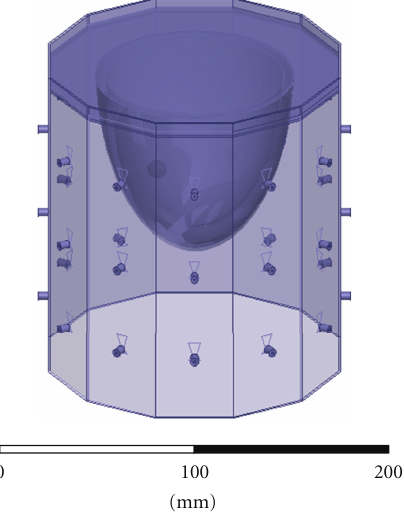
Figure 16: HFSS CAD numerical breast phantom with skin layer, fat layer, glandular tissue, and chest wall of Example 3. The inclusion is 1cm in diameter with relative permittivity and conductivity contrasts of 2:1.